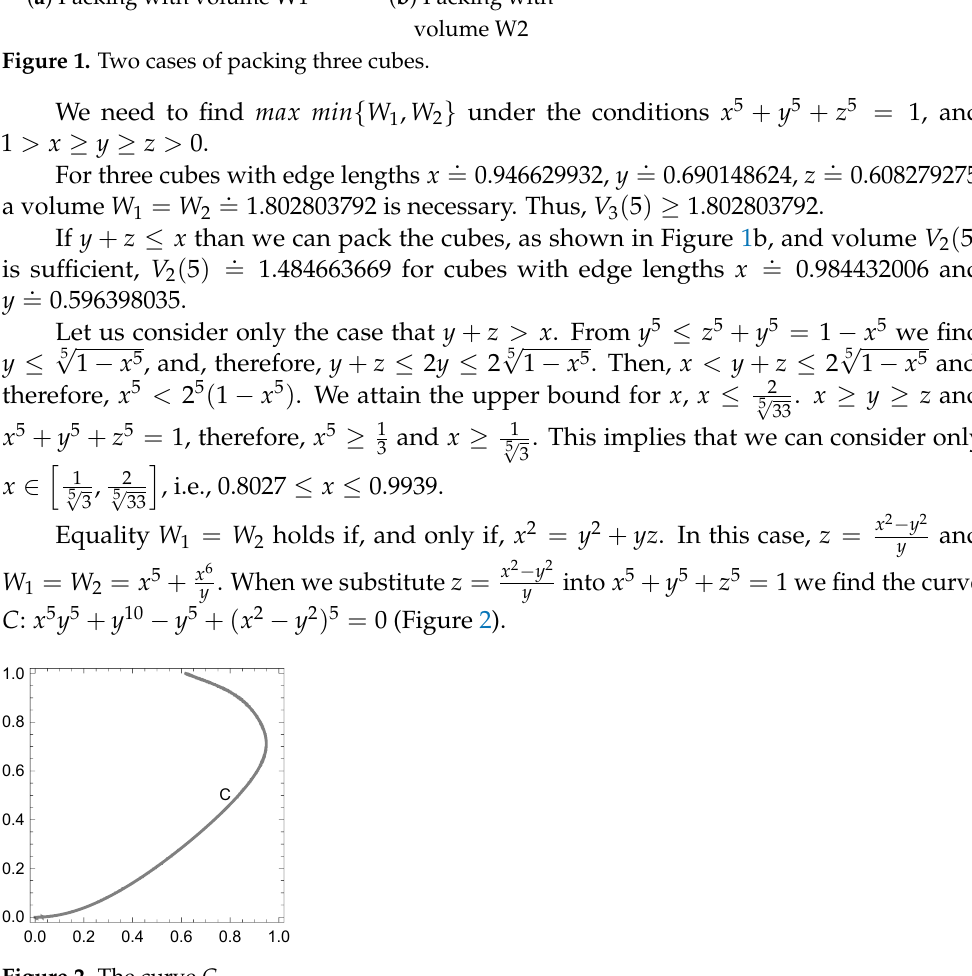
Figure 2. The curve C